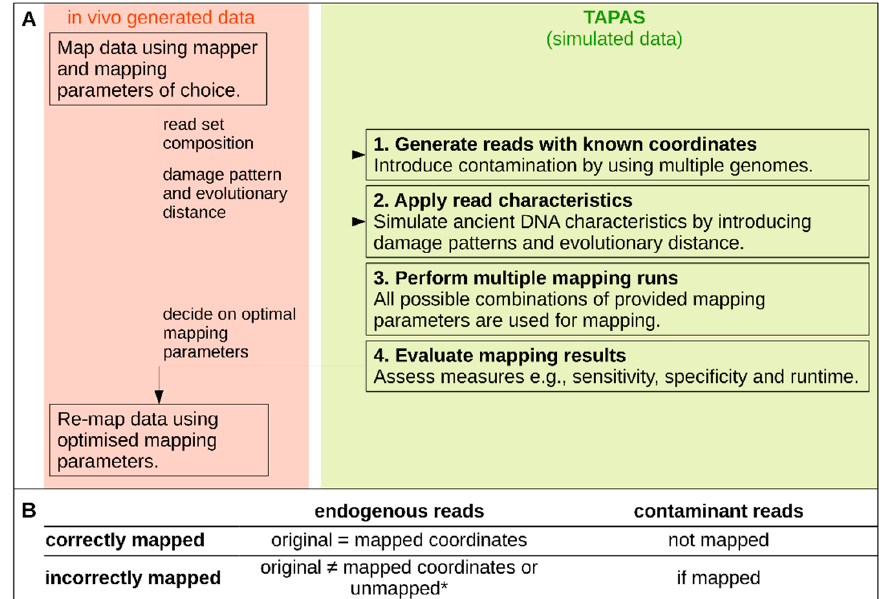
Figure 1. ( A ) Schematic of the TAPAS (Testing of Alignment Parameters for Ancient Samples) tool indicating a typical workflow from in vivo data to mapping assessment. ( B ) Different classes of reads that TAPAS assigns* incorrect and unmapped reads are by default not independently considered but can be distinguished if needed.